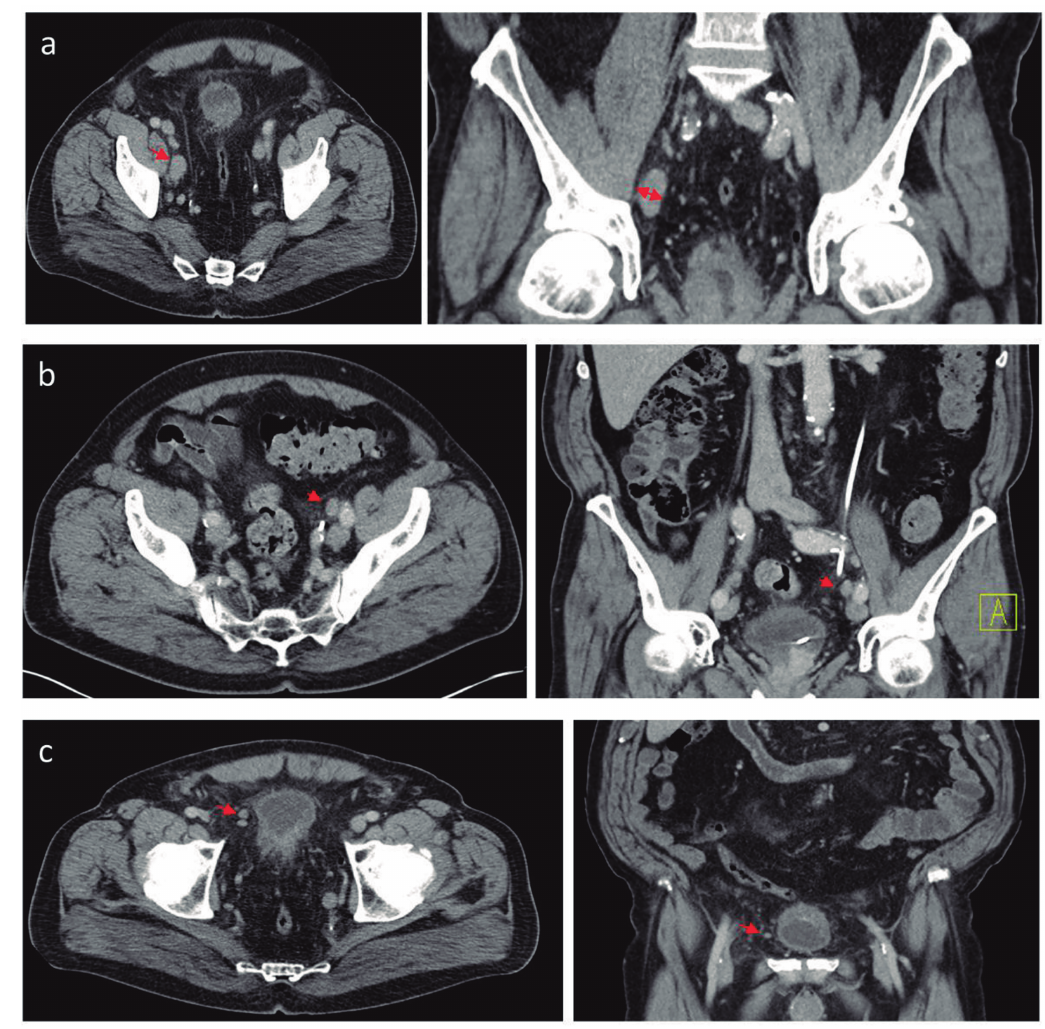
Figure 1 - Morphological characteristics of lymph nodes in CT scan Representative pelvic CT scan showing lymph node characteristics such as size (A), morphology (B) and loco-regional number (C) in transversal and coronal plane.